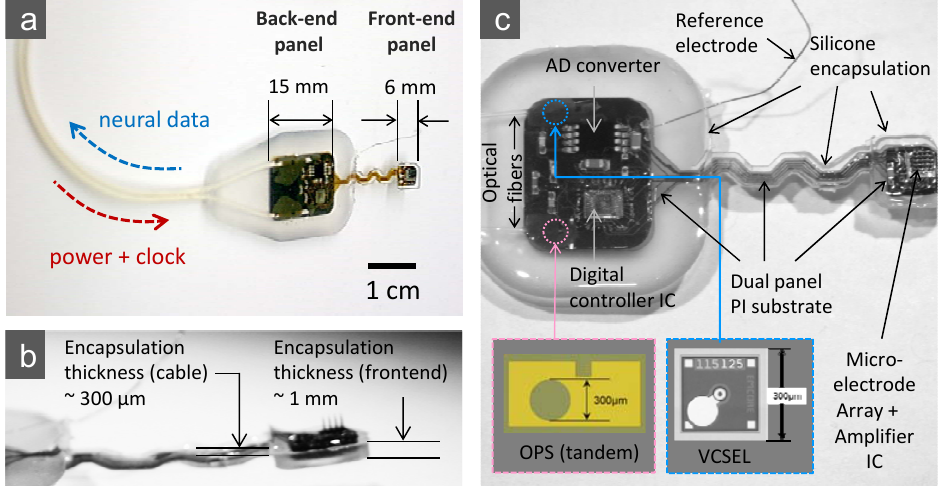
Figure 4. Photograph of the completed microsystem detailing the layout of peripheral microelectronic and (infrared) telemetry components. ( a ) Overall microsystem structure with front- and back-end dimensions; ( b ) side view of the encapsulation profile at the front- and back end connection (serpentine metal patterns and thinner encapsulation for the better flexibility); ( c ) images of the electronic and optoelectronic components in the microsystem—microscope images of the optical power supply (OPS) and VCSEL optoelectronic device components are shown separately at the